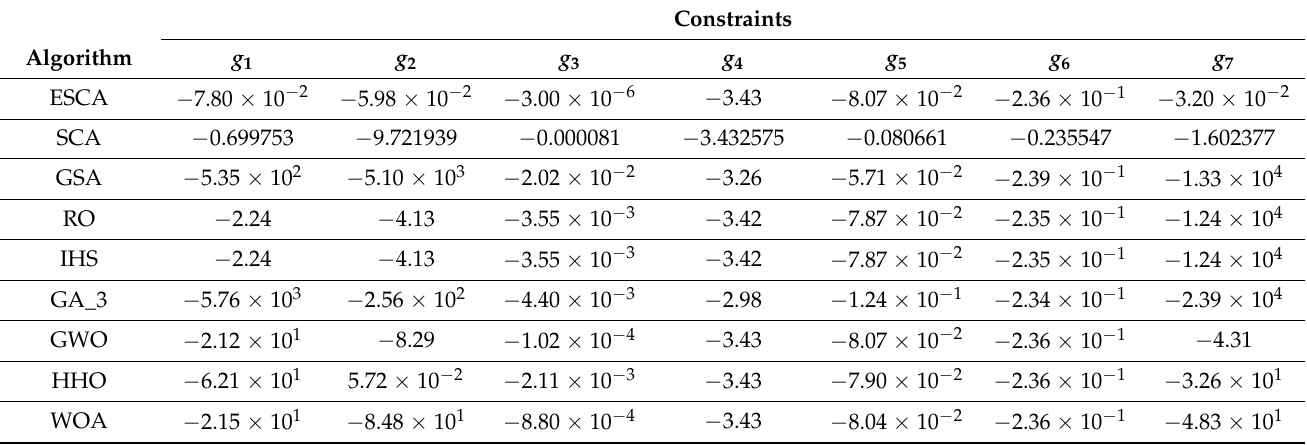
Table 27. Welded Beam problem. Constraints.